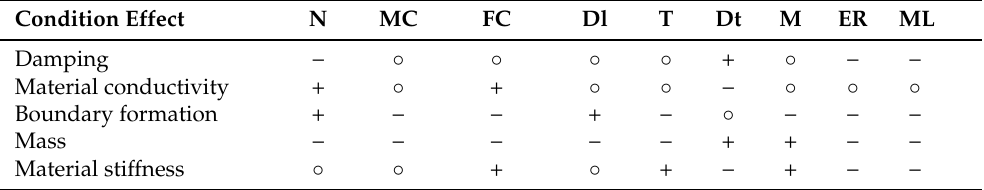
Table 2. Relationship between environmental conditions and local properties of composite material: ( ◦ ) average, (+) strong, and (−) weak influence; (N) Notch, (FC) Fiber crack, (MC) Matrix crack, (Dl) Delamination, (Dt) Dirt, (T) Temperature, (M) Moisture, (ER) Electromagnetic Radiation and (ML) Mechanical Load [58].